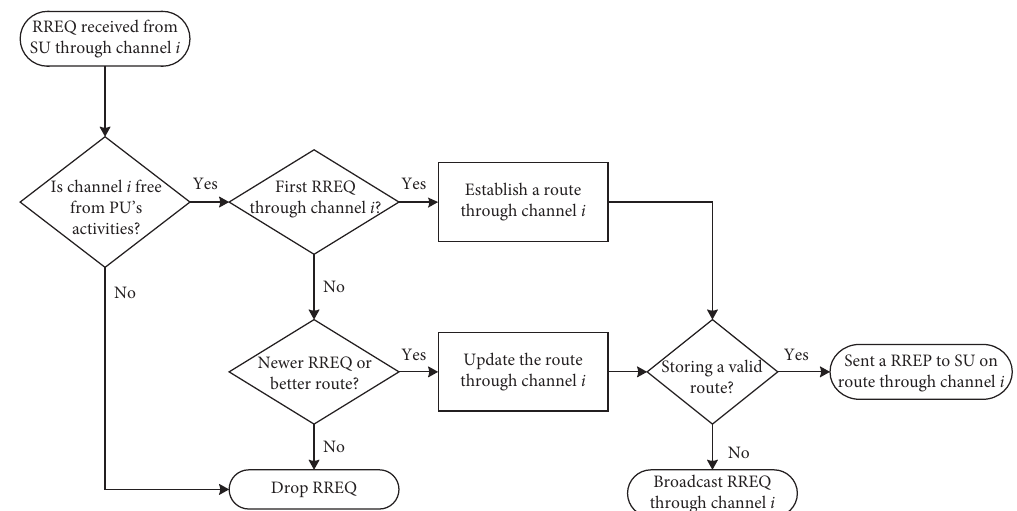
Figure 5: RREQ mechanism in proposed MCSUI